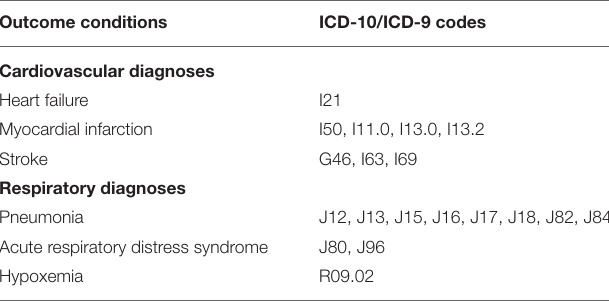
TABLE 1 | Diagnosis codes for analyzed outcomes and